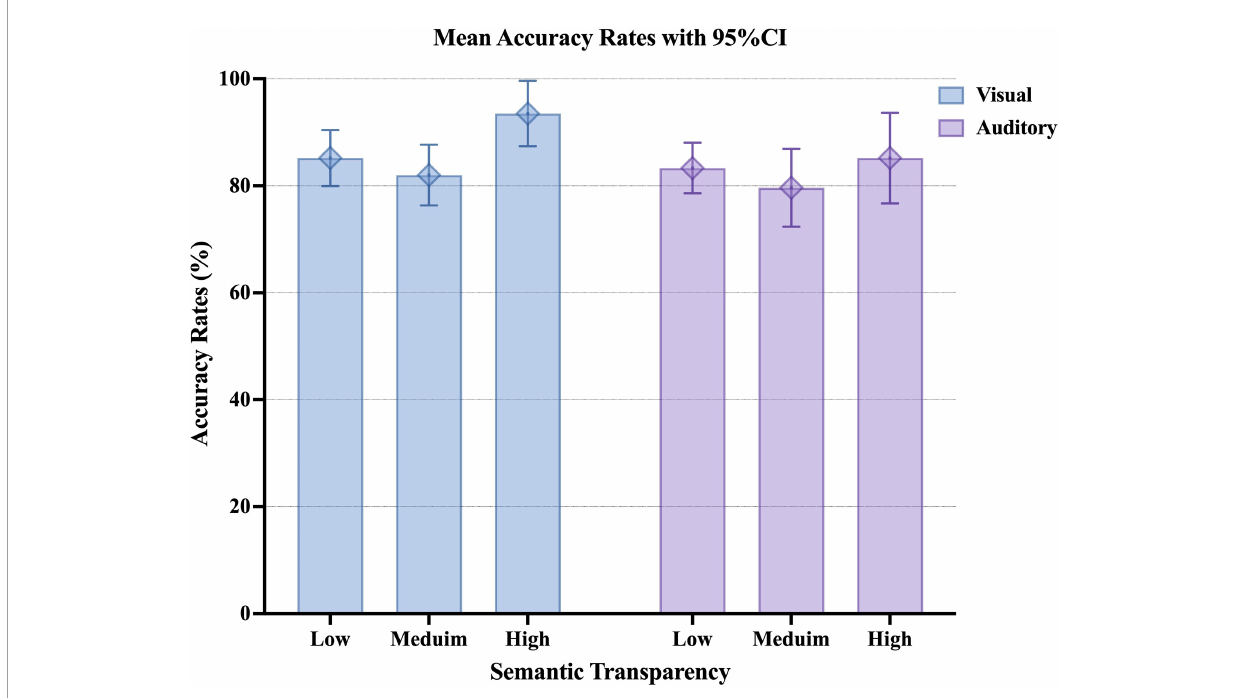
FIGURE3 Graph of the mean accuracy rates upon visual or auditory presentation of Japanese collocations with different degrees of semantic transparency. The error bar shows the 95% CI.